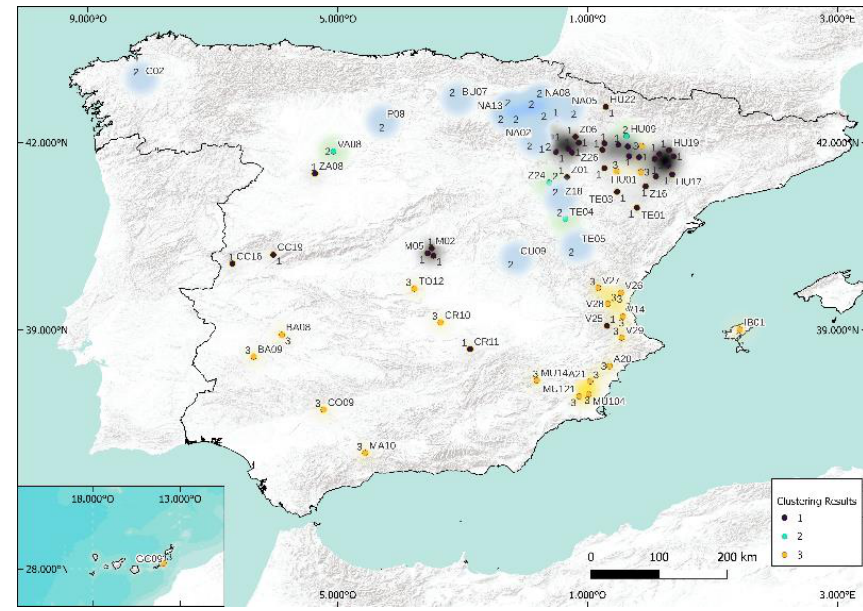
Figure 16. Using k-means for 3 clusters.